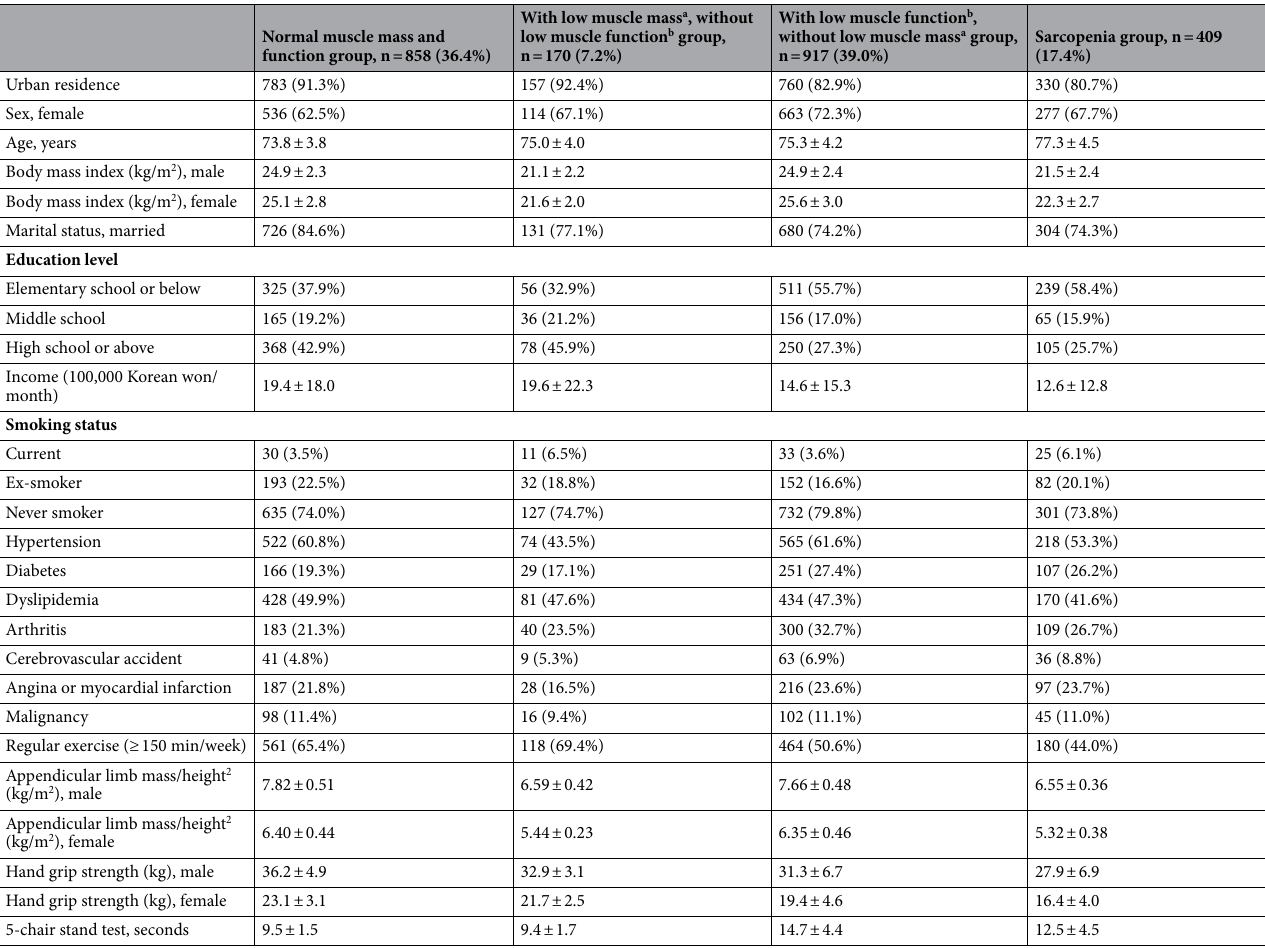
Table 2. Characteristics of the participants according to the subgroups following the AWGS algorithm. Values are presented as numbers (% of total) or mean ± standard deviations. a Appendicular lean mass/height 2 < 5.7 kg/ m 2 in female and appendicular lean mass/height 2 < 7 kg/m 2 in male. b Handgrip strength < 18 kg in female and < 28 kg in male and/or 5-time chair standing test > 12